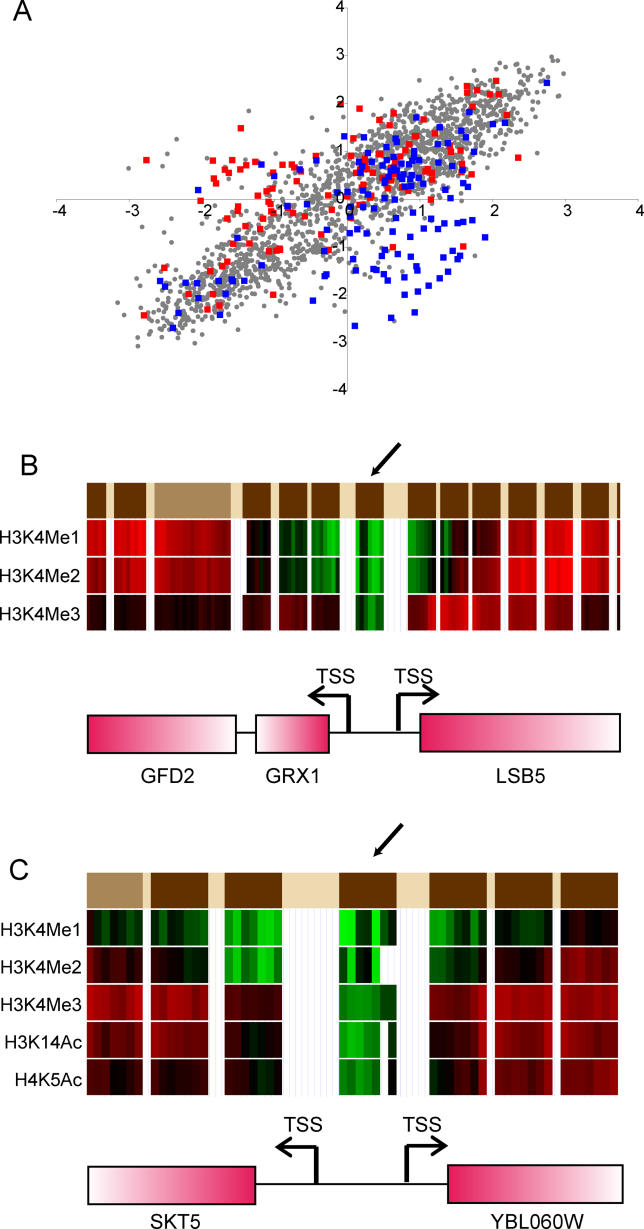
Modification Boundaries(A) H3K4Me3 boundaries occur across TSSs. The x-axis represents the level of H3K4Me3 for a given nucleosome, and the y-axis represents the level of this modification for the preceding nucleosome. Pairs of nucleosomes flanking the TSS for a gene on the W strand are plotted as blue squares, and pairs flanking TSSs for genes on the C strand are plotted as red squares. Remaining nucleosome pairs are plotted as grey circles.(B) Example of a punctate nucleosome. Histone modification plotted as in Figure 1B for a subset of histone modifications. Arrow indicates a nucleosome whose modification pattern differs significantly for H3K4Me3 from nucleosomes to either side. Gene names are as labelled.(C) Example of a punctate nucleosome, labelled as in (B).